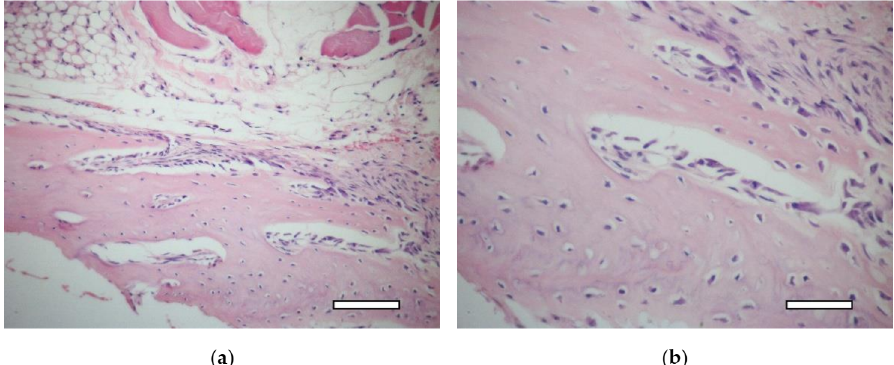
Figure 14. 2nd group (MSC only), 1 week. Osteoid formation with randomly located osteoblasts near the implant. Staining with hematoxylin and eosin. ( a ) objective lens × 20, scale bar—100 µ m; ( b ) objective lens × 40, scale bar—50 µ